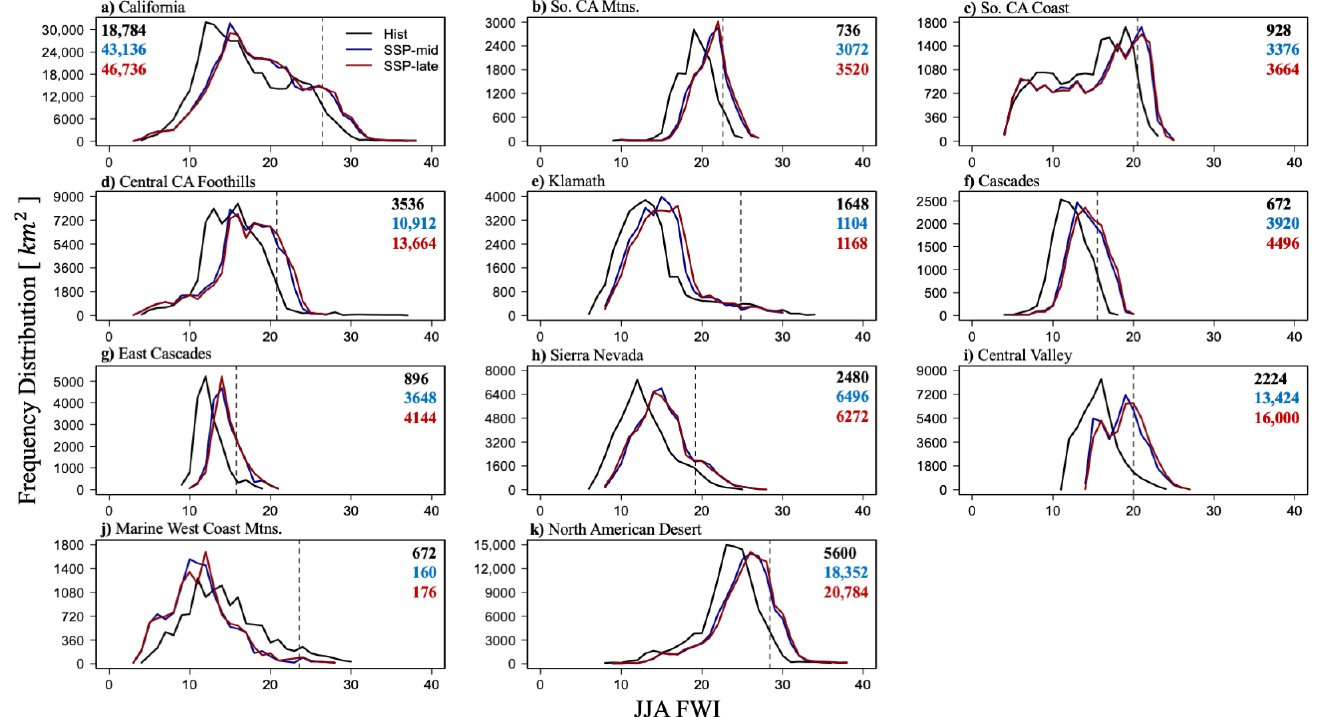
Figure 8. Frequency distribution depicting the area experiencing particular JJA FWI values. The dashed line represents the ecoregion specific 30 year average spatial 95th percentile value. The black, blue, and red lines represent the historical, mid-century, and late-century time periods, respectively. The color-coded text are areal units (km 2 ) experiencing greater than the 95th percentile value for that ecoregion. ( a ) California; ( b ) Southern California Mountains; ( c ) Southern California Coast; ( d ) Central California Foothills; ( e ) Klamath; ( f ) Cascades; ( g ) East Cascades; ( h ) Sierra Nevada; ( i ) Central Valley; ( j ) Marine West Coast Mountains; ( k ) North American Desert. The total land area that was projected to experience FWI greater than the 95th